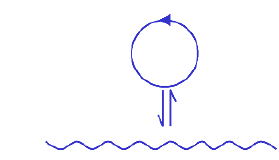
Figure 1. Maturana and Varela’s ideograms to denote structurally-determined autopoietic and organizationally-closed systems. The arrow circle